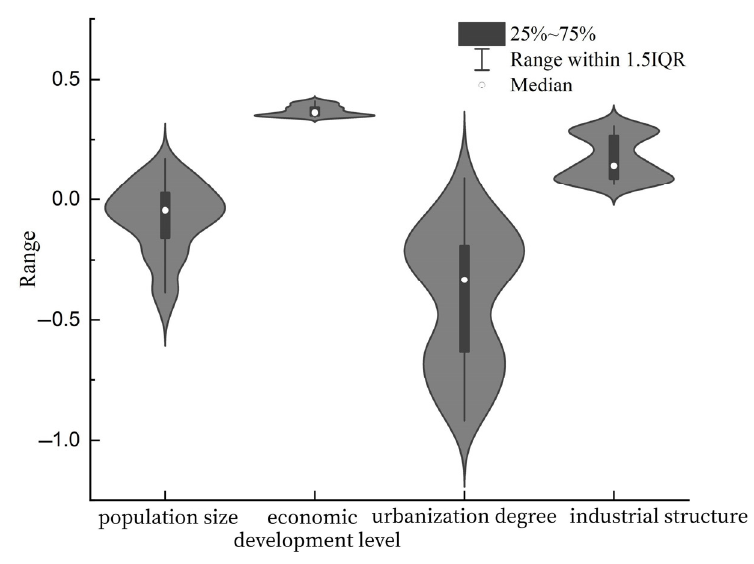
Figure 8. The Violin map of the MGWR Model Analysis of Factors Affecting Carbon Emission Intensity in the Yangtze River Delta.